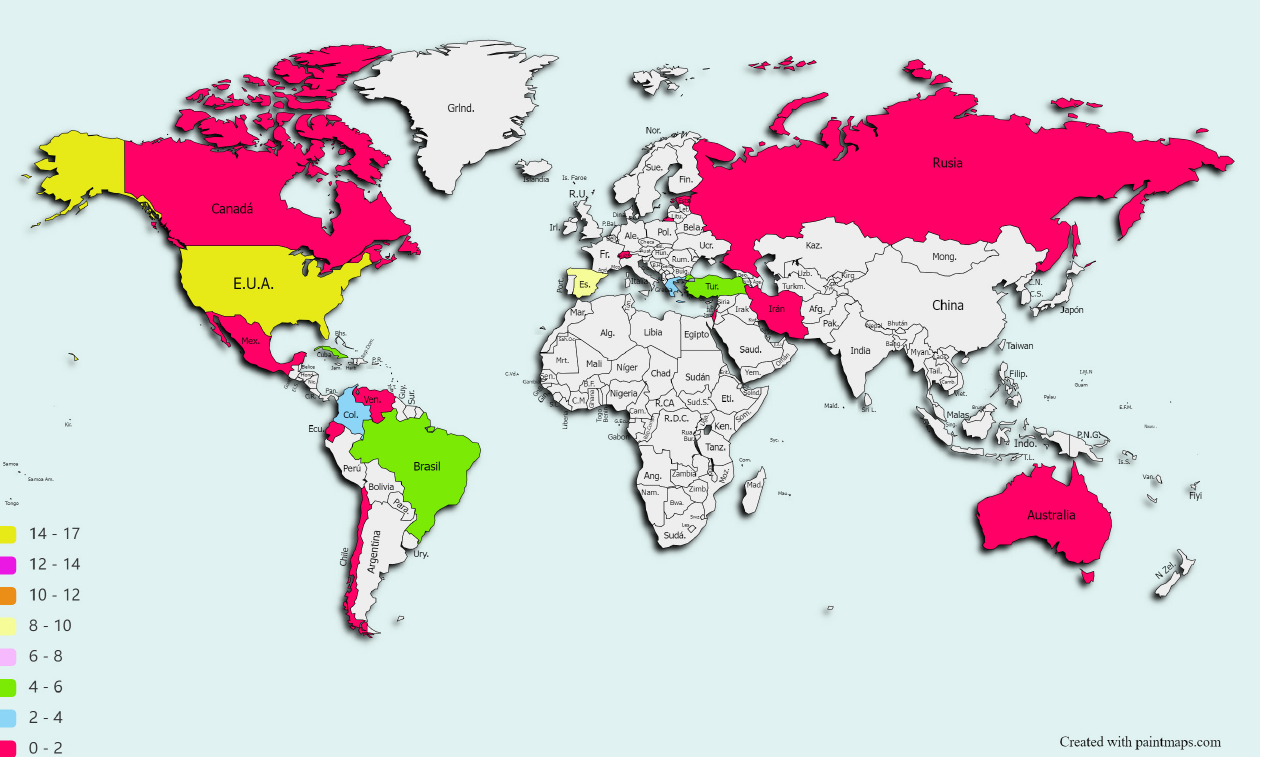
Fig. 5. Number of items selected for each country in the world